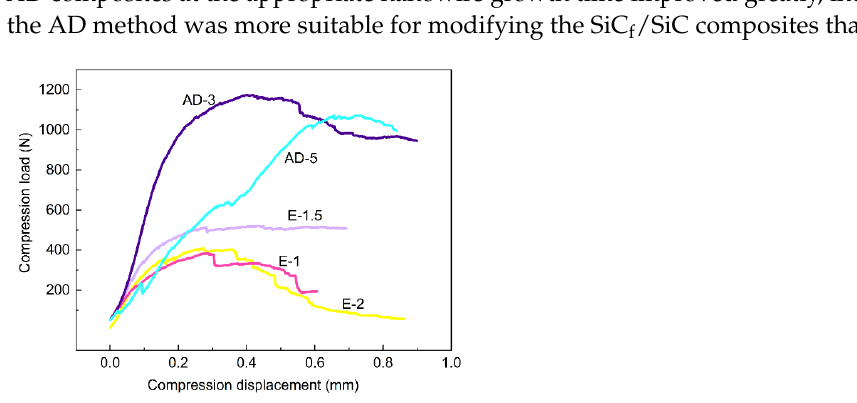
Table 2. Mechanical properties of SiC f /SiC composites prepared by EP and AD methods.